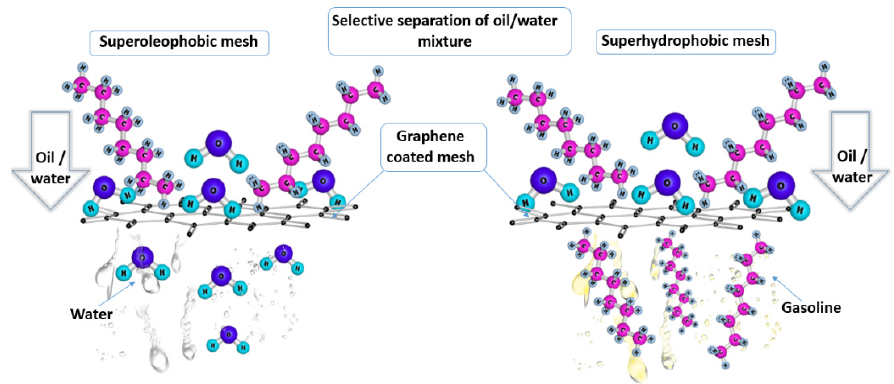
Figure 5. Selective separation of an oil/water mixture (gasoline and water) using a graphene-coated mesh.